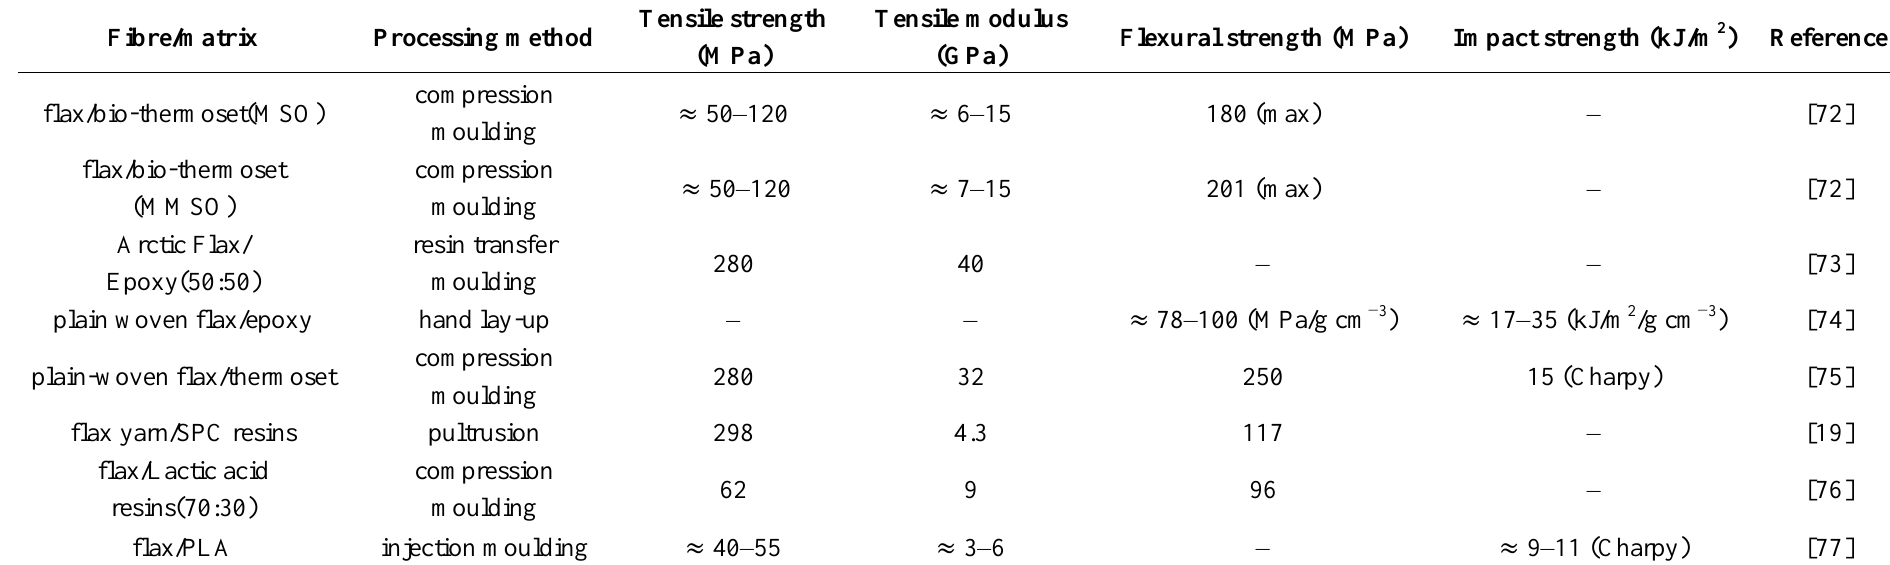
Table 5. Testing data of mechanical properties of flax reinforced